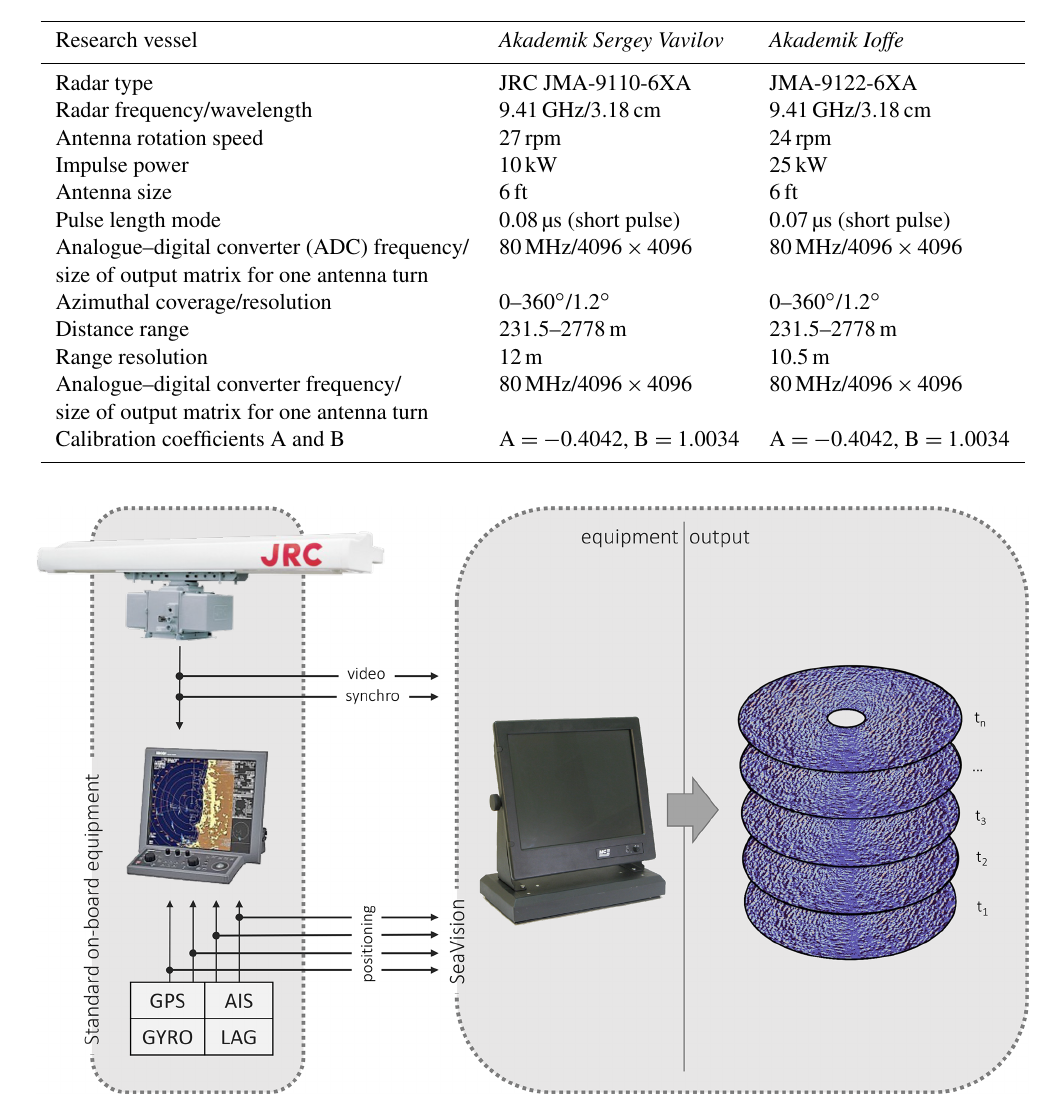
Figure 2. SeaVision integration to the ship’s navigational equipment together with an example of the series of the geographically stabilized (northward) sea clutter images, one for each antenna turn (right column). The image of the JRC radar scanner (top left) is taken from http://www.jrc.co.jp/eng/index.html (last access: 4 August